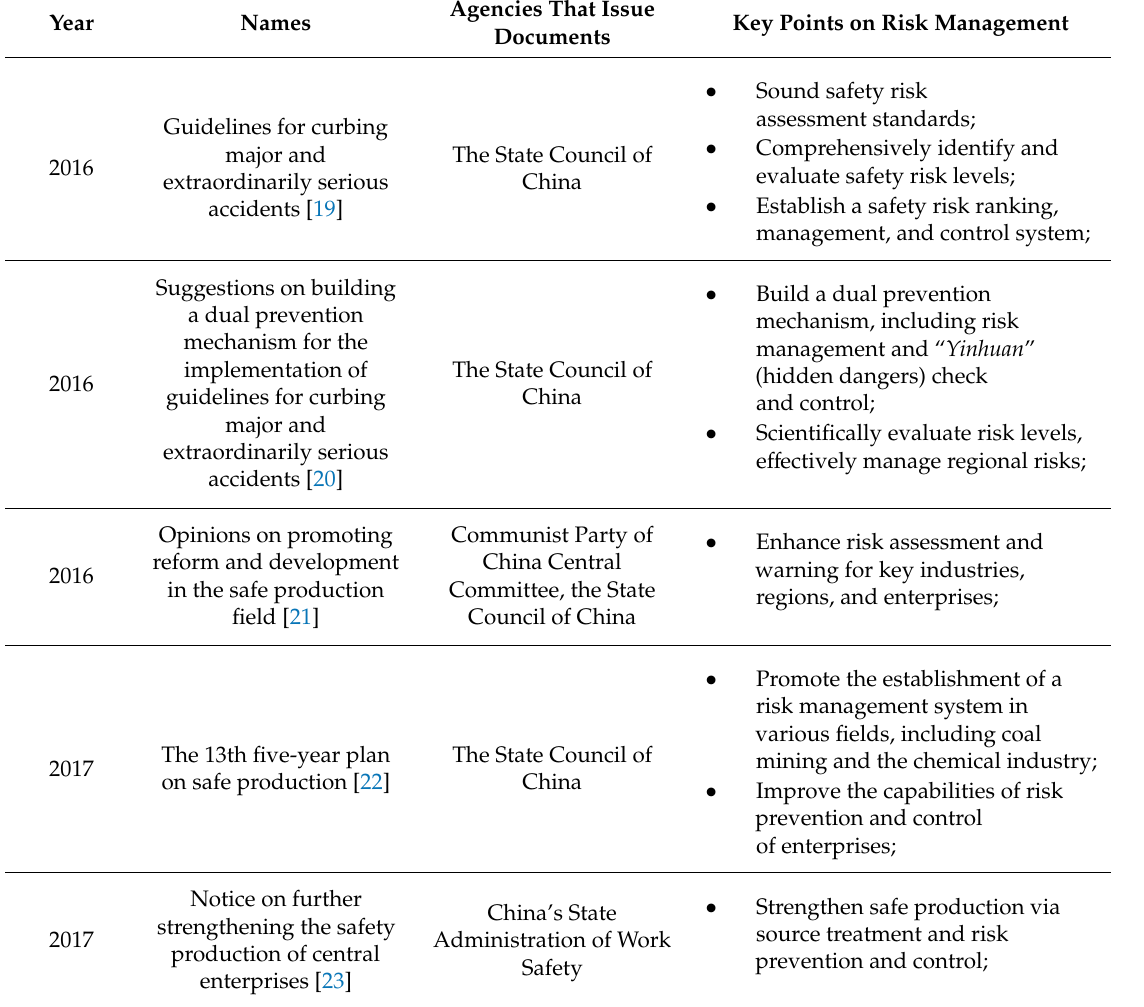
Table1. RepresentativeChinesegovernmentdocumentsrelatedtoriskmanagementandtheinformation within from five recent